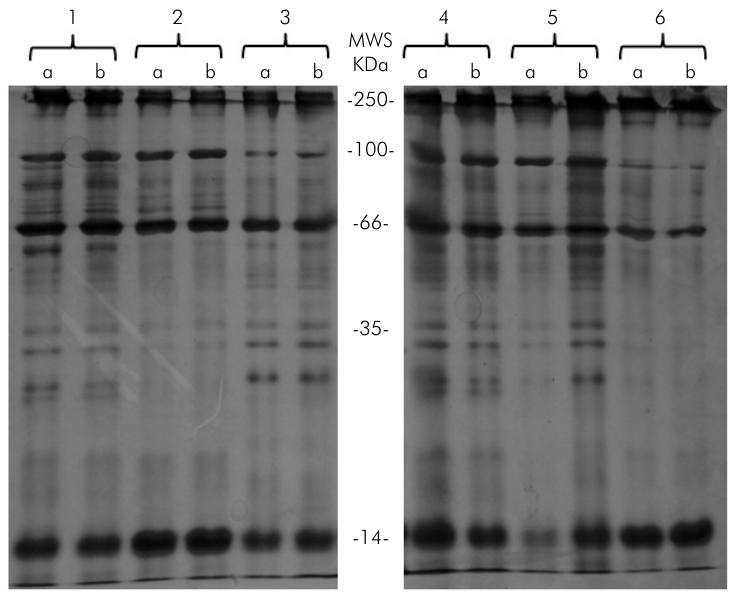
The letter “a” indicates control grou, the 1b, 2b, and 3b are the salivary protein pattern after mixture with pill suspension and 4b, 5b, and 5b after mixture with syrup. Figure 3. Electrophoresis demonstrating no difference among